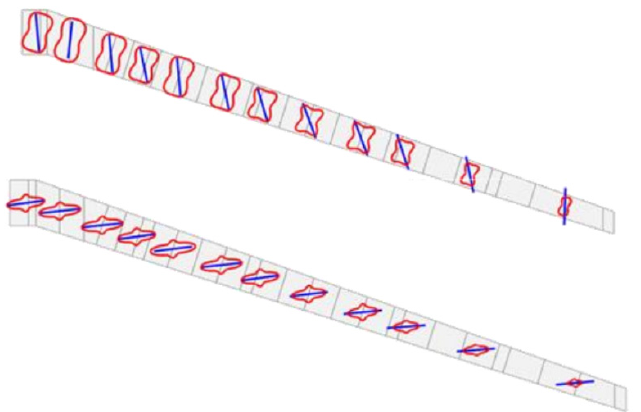
Figure 5. Polar distribution of in-plane stiffness term 𝐴11 in the reference design ( top ) and tailored design ( bottom ), for the upper skin.